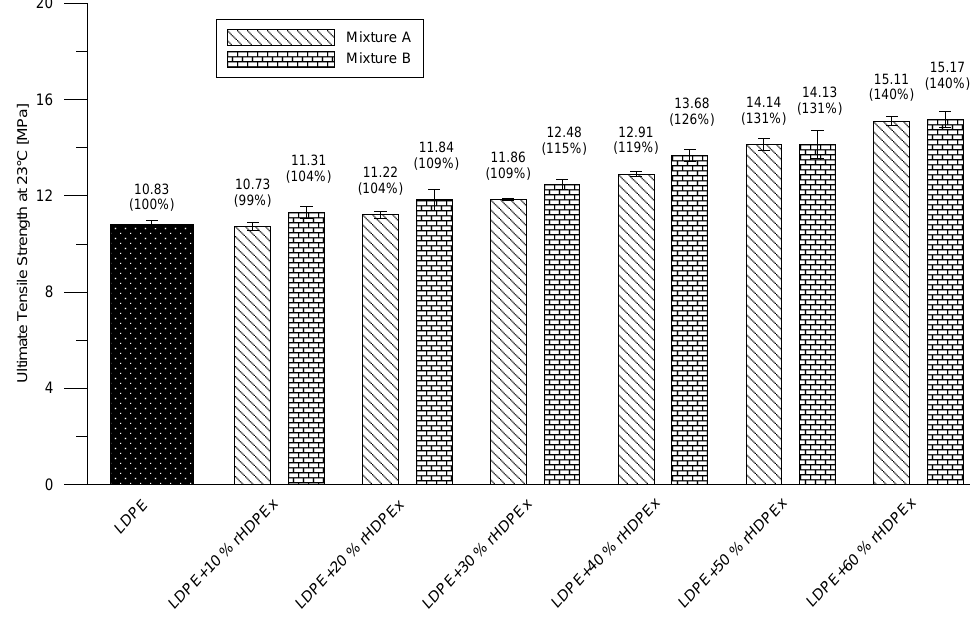
Figure 6. Ultimate tensile strength at ambient temperature—Mixtures A and